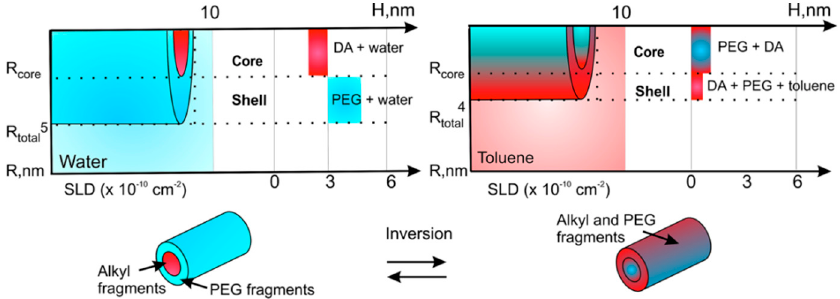
Figure 3. Scheme of the inversion for D3 (DA—dodecanedioc acid moiety) (reprinted with permission from [125], American Chemical Society).